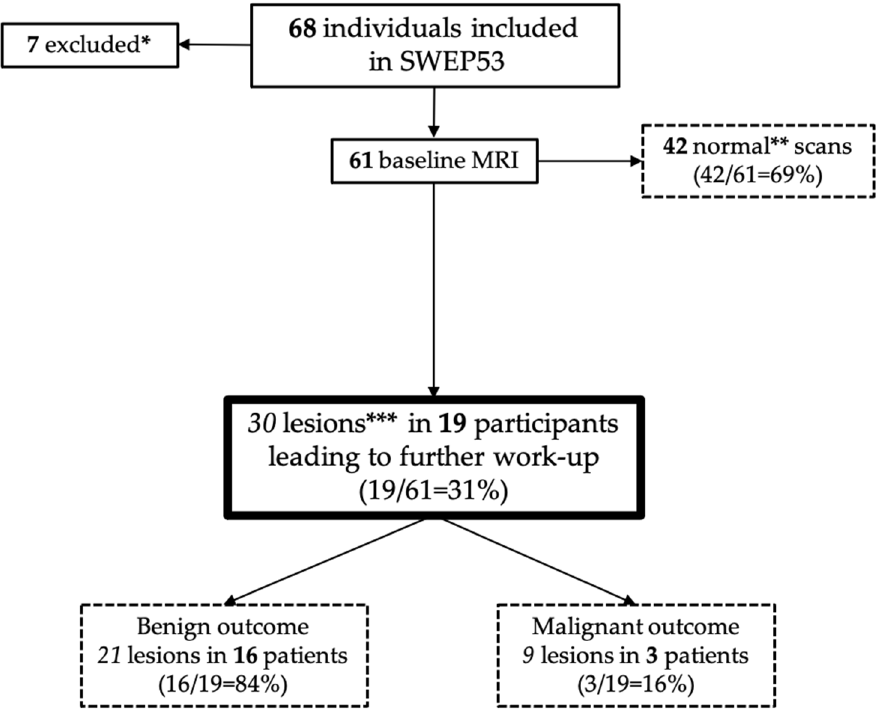
Figure 2. Flowchart of included individuals in SWEP53 and their imaging outcomes. * Two patients were not eligible for WB-MRI due to recurrent disease/new cancer diagnosis; two participants had not yet undergone WB-MRI. One person could not perform MRI due to pain; one withdrew consent for the study; one pending result. ** Normal scans = do not require any further workup. ***